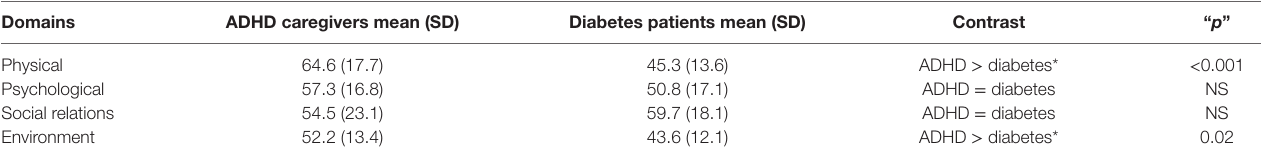
TaBle 3 | comparison of WhOQOl-Bref domains mean scores of aDhD caregivers and diabetes patients with depressive symptoms. Domains